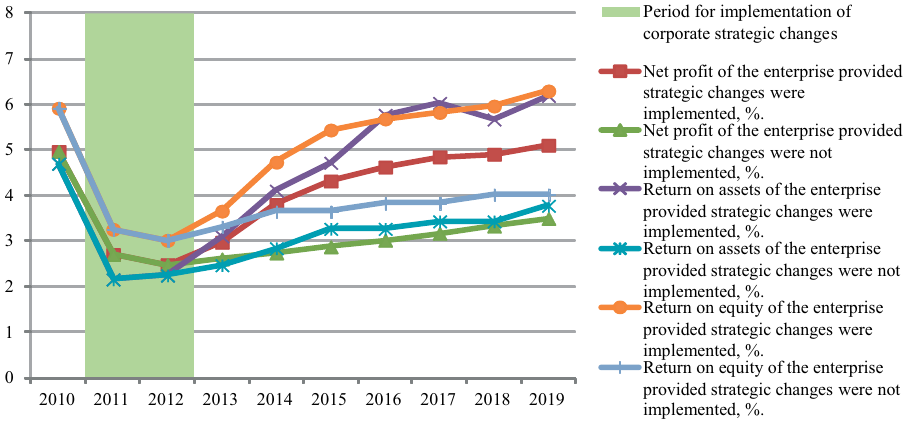
Fig. 5. Dynamics of indicators of enterprise revenue preservation